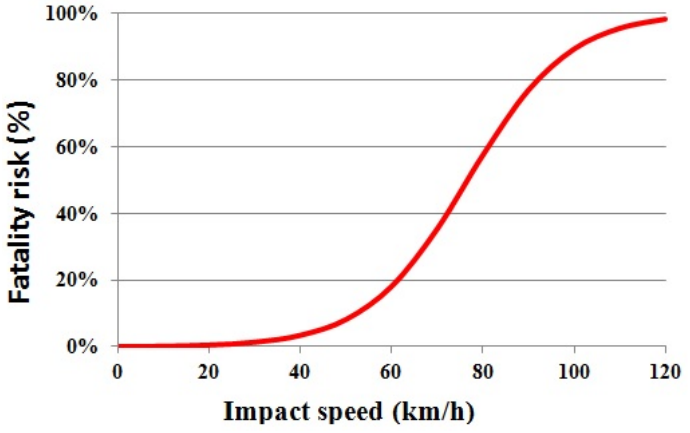
Figure 2. Risk of pedestrian fatality for different impact speeds (fatality rate is the percentage of pedestrians that are killed in a collision with a motorized vehicle).